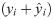
Spatial Residuals of Regression Model in 100 Districts of Hamburg.Shown is the difference between EHEC/HUS cases and those estimated by the model in Table 2A, i.e., (yi+y^i) per neighborhood i.